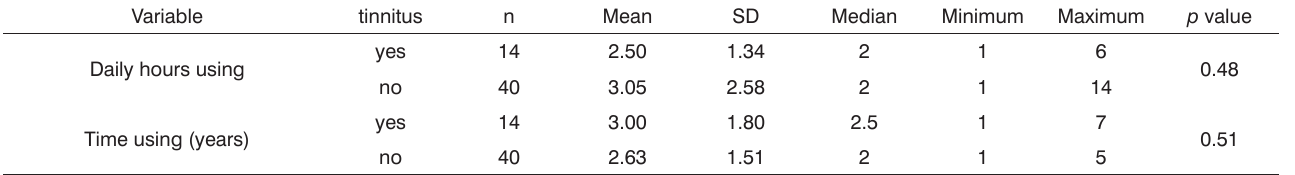
Table 2. Analysis of variables in patterns of use of personal stereo devices relative to tinnitus.